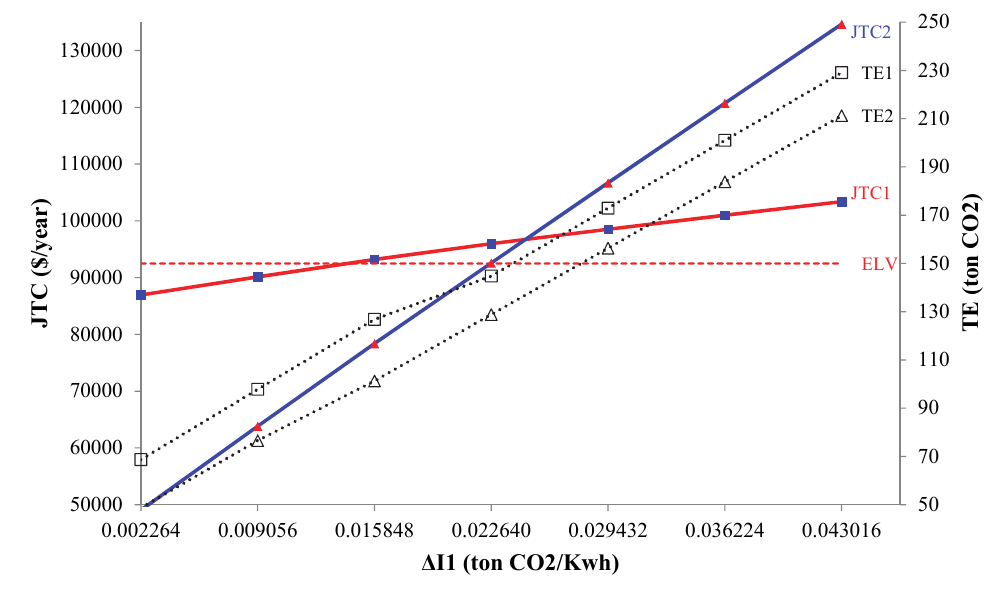
Fig. 17. Effect of changing in industrial indirect emission factor on total cost and total